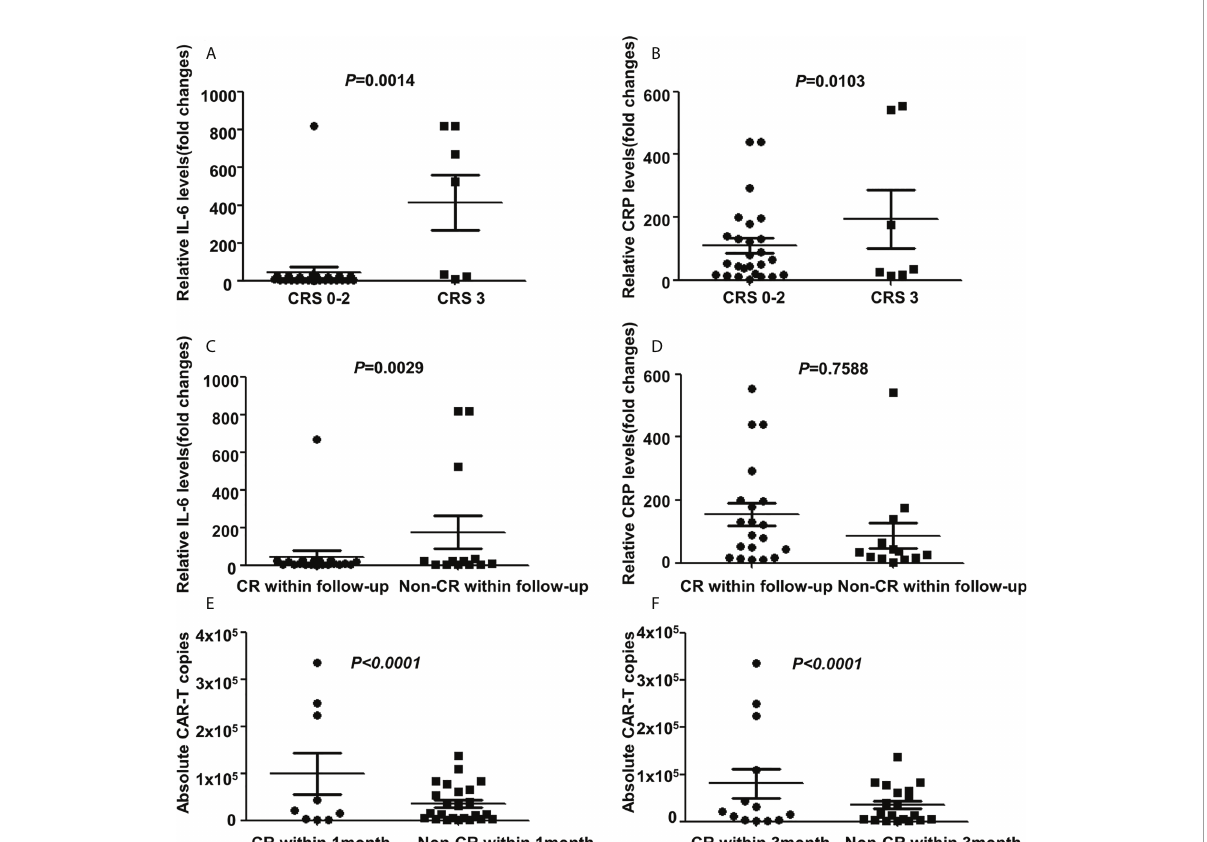
FIGURE 3 Cytokines and CAR-T copies in 33 R/R DLBCL patients. (A, B) Changes of IL-6 and CRP levels in patients with different CRS grades after CAR-T therapy. Signi fi cant higher IL-6 and CRP levels were detected in cases with grade CRS 3 than in that cases with grade CRS 0-2 ( P =0.0014 and P =0.0103 respectively two-way ANOVA, shown are means±SD; n1=7, n2=26). (C, D) Changes of IL-6 and CRP levels in patients with different responses after CAR-T therapy. Patients achieving CR during follow-up period has a lower IL-6 increase than patients without achieving CR ( P =0.0029, two-way ANOVA, shown are means±SD; n1= 20, n2=13), while CRP had no difference in both groups( P =0.7588, two-way ANOVA, shown are means±SD; n1=20, n2=13). (E, F) Changes of CAR-T copies in patients with different response after CAR-T therapy. Relatively higher CAR-T copies were observed in cases that achieved CR than cases without CR within 1 month( P<0.0001 , two-way ANOVA, shown are means ±SD; n1=9, n2=24) or 3 months( P<0.0001 , two-way ANOVA, shown are means±SD; n1=13, n2=20). Note: CR for complete remission; CRS for cytokine release syndrome; IL-6 for Interferon-6; CRP for c-reactive